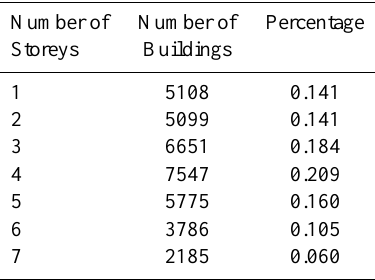
Table 4. Number of buildings according to number of stories. Number